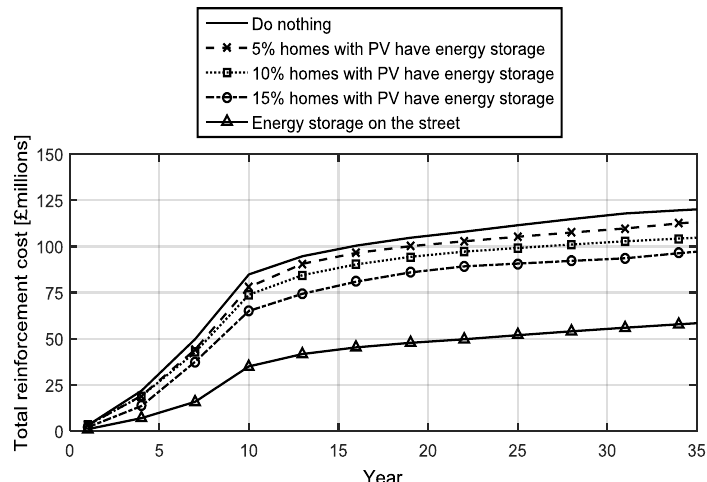
Figure 9. Total reinforcement cost when the DNO has to re-conductor despite either storage in homes or located by the DNO to prevent overvoltage, high PV scenario. The cost of storage is only included in the ‘energy storage on the street’ case as only the costs to the DNO are considered.